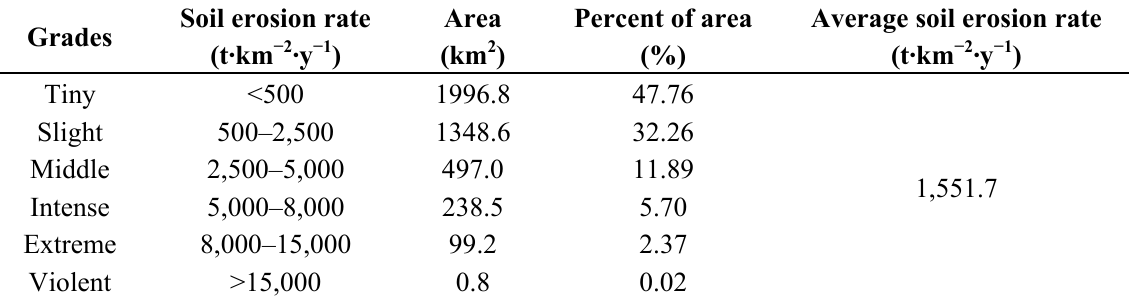
Table 2. Grades of soil erosion intensity predicted by AnnAGNPS for the watershed.